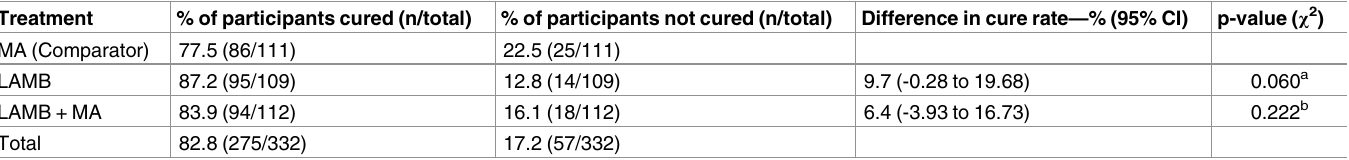
Table 2. Treatment efficacyat six months follow-up as per ITT